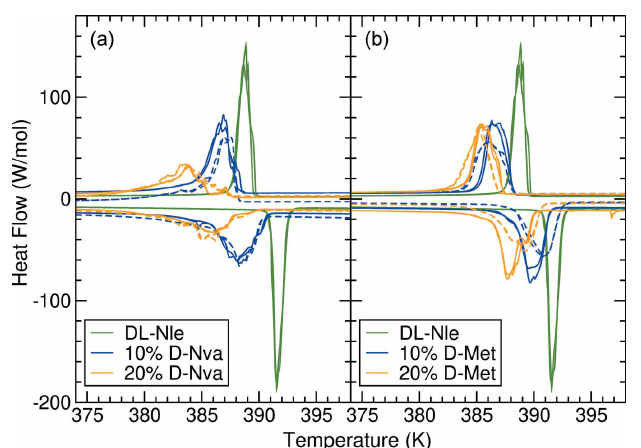
Figure 11 DSC diagrams of the (cid:2) ! (cid:6) transition in pure dl -Nle crystals (green) and crystals with 10 or 20% impurities of ( a ) d -Nva or ( b ) d -Met. Dashed and solid curves represent crystals grown from different batches and illustrate the reproducibility of the results.